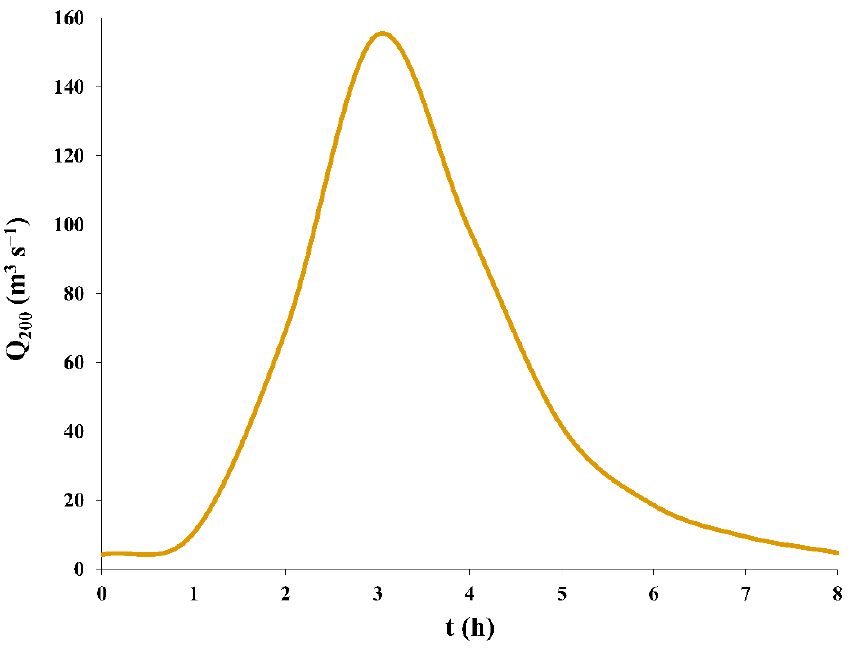
Figure 5. Hydrological hydrograph for Morra Creek associated with a return period T of 200 years, indicated in the present study as Q 200 (m 3 s − 1 ) and t (h) is the time.